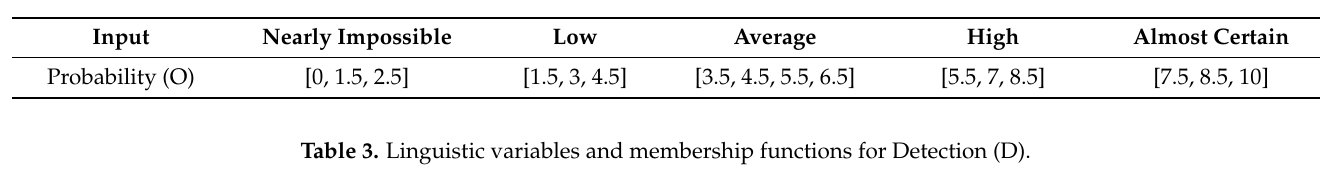
Table 2. Linguistic variables and membership functions for Probability of the event occurring (P).